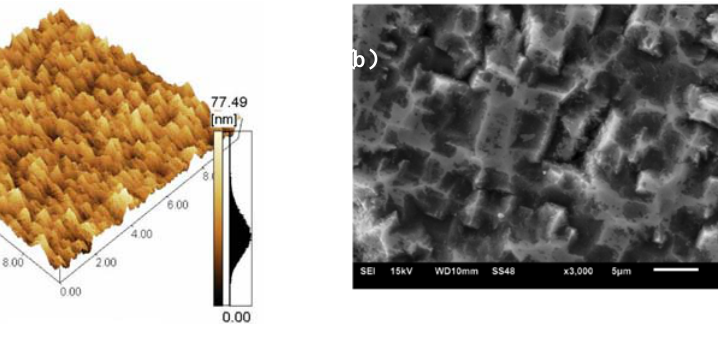
Table 1. Experimental matrix for nano-impact (low-cycle fatigue) testing. Impact Sl. load, No. P (mN)